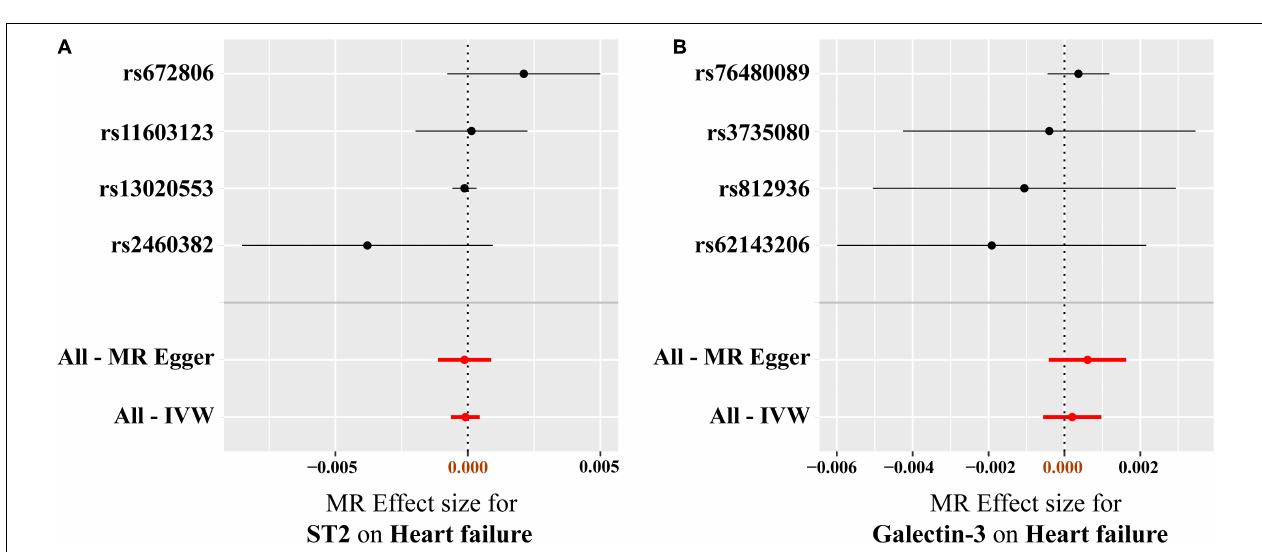
FIGURE 4 | MR-Egger and fixed-effect IVW analysis of the causal association between circulating ST2 and galectin-3 levels and heart failure risk. (A) ST2, (B) galectin-3. Forest plots reflect the causal effect of individual SNPs on heart failure. Black dots represent the estimated betas, and horizontal lines represent the 95% CI of the betas. IVW, inverse variance weighted; SNPs, single-nucleotide polymorphisms; CI, confidence interval; MR, Mendelian